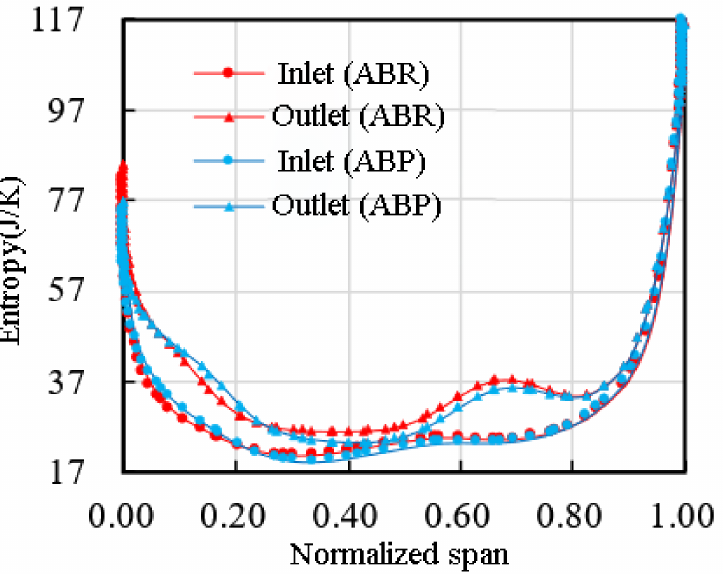
Figure 10. The entropy distribution along span at the inlet and outlet of the fifth stage under peak total efficiency